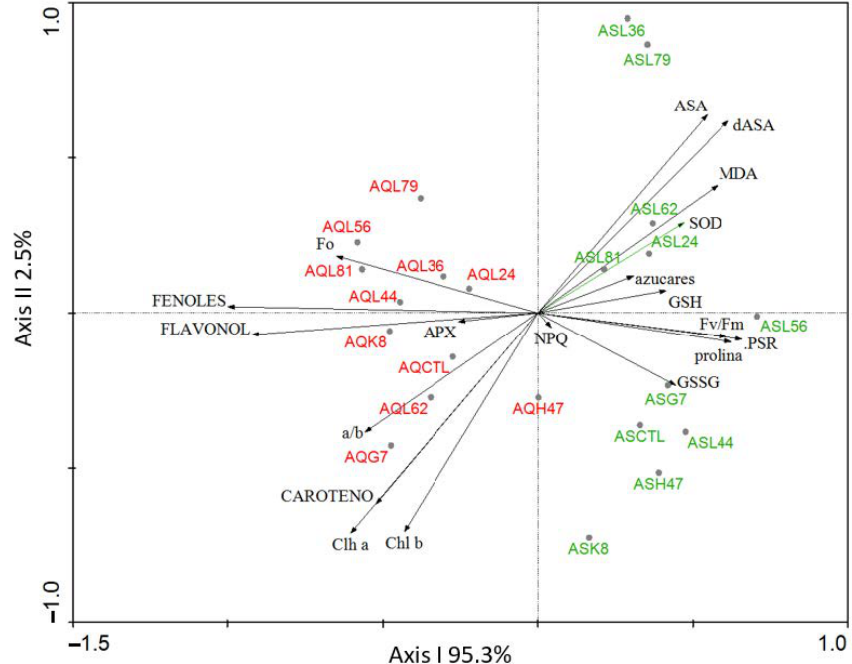
Figure 1. Principal component analysis (PCA) performed with data from physiological, metabolic and oxidative stress markers from AS and AQ inoculated with the 10 PGPB (G7, H47, K8, L24, L36, L44, L56, L62, L79, L81), and non-inoculated controls (CTL). Chl a, Chlorophyll a; Chl b, Chlorophyll b, a/b, ratio Chla/Chlb; CAROTENO, Carotenoids; azucares, Soluble sugars; prolina, proline; FENOLES: Phenols; FLAVONOL: flavonols; SOD, Superoxide Dismutase; APX, Ascorbate Peroxidase; GSH, reduced Glutathione; GSSG, oxidized Glutathione; AsA, reduced Ascorbic; dAsA, oxidized ascorbic acid; F 0 , minimum fluorescence; Fv/Fm, maximal PSII quantum yield; Fv, maximal Fluorescence; NPQ, non-photochemical quenching; PSR: the effective PSII quantum yield. Varianze absorbed by each axis is represented on the figure.